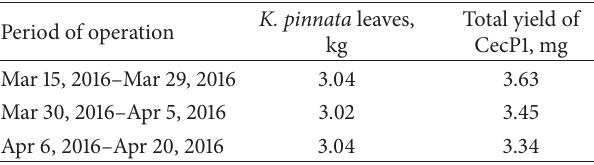
Table 1: Reproducibility of manufacturing K. pinnata extracts containing